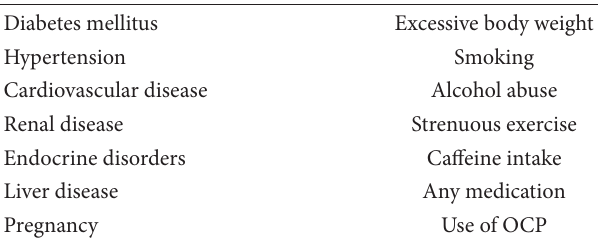
Table 1: Exclusion criteria based on history and clinical examina-